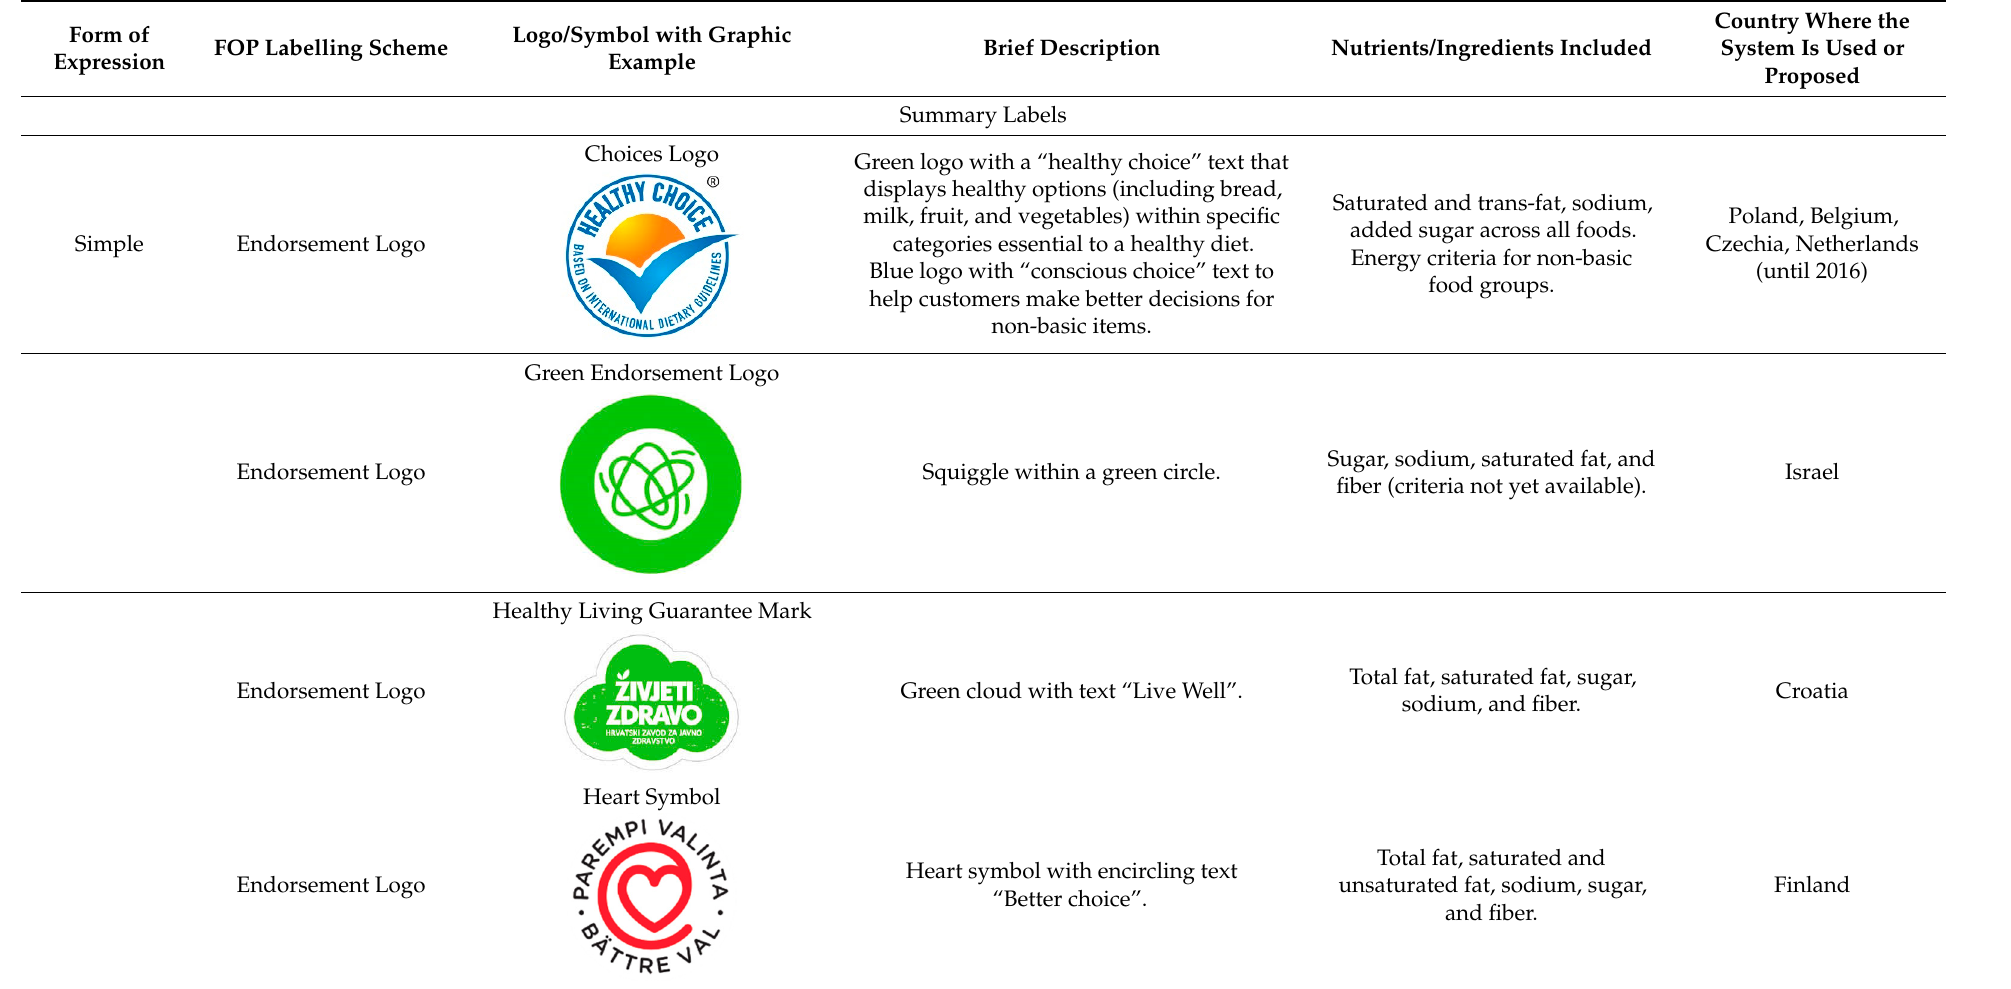
Table 1. Front of Package labelling scheme used in various countries to classify food into categories of relative healthfulness.